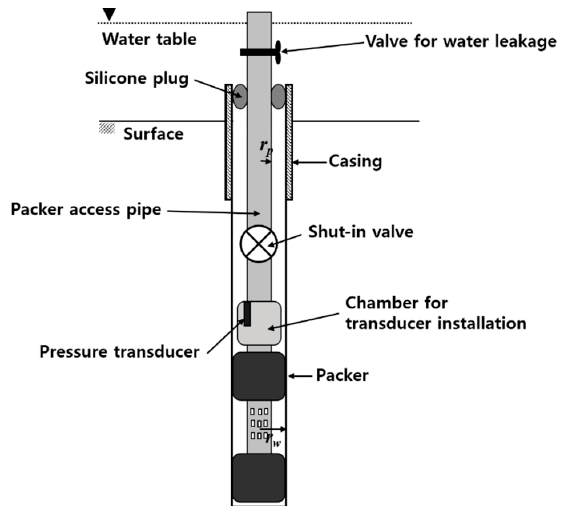
Figure 2. Double packer system for pulse, slug, and constant head withdrawal tests at the test zone under artesian condition.